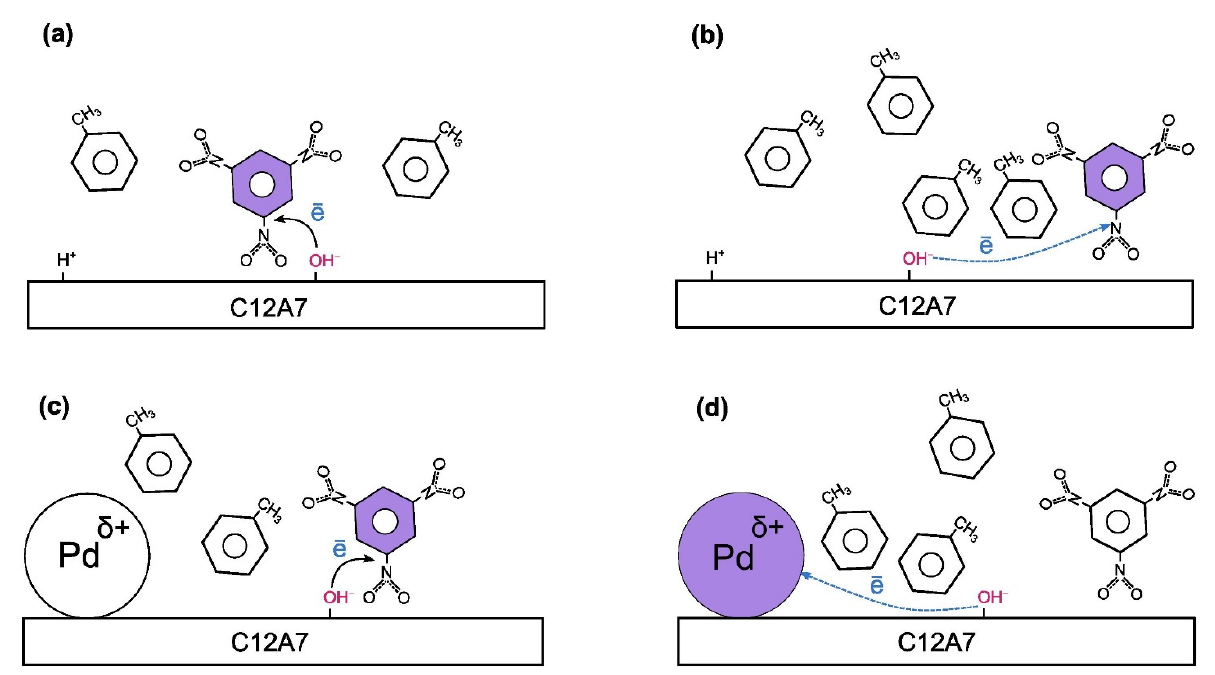
Figure 4. Scheme of the formation of TNB radical anions after interaction with surface donor-sites. The final electron acceptor is shown in purple. ( a ) Fast formation of a TNB radical anion after adsorption over C12A7. ( b ) Slow formation of a TNB radical anion over C12A7 after heating. ( c ) Fast formation of a TNB radical anion after adsorption over Pd-C12A7. ( d ) Slow electron transfer to Pd nanoparticle instead of TNB over Pd-C12A7.